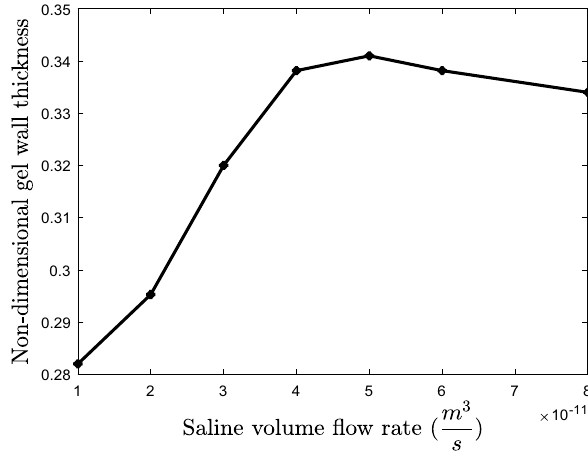
Fig. 12 Changes in gel wall thickness as a function of saline volume flow